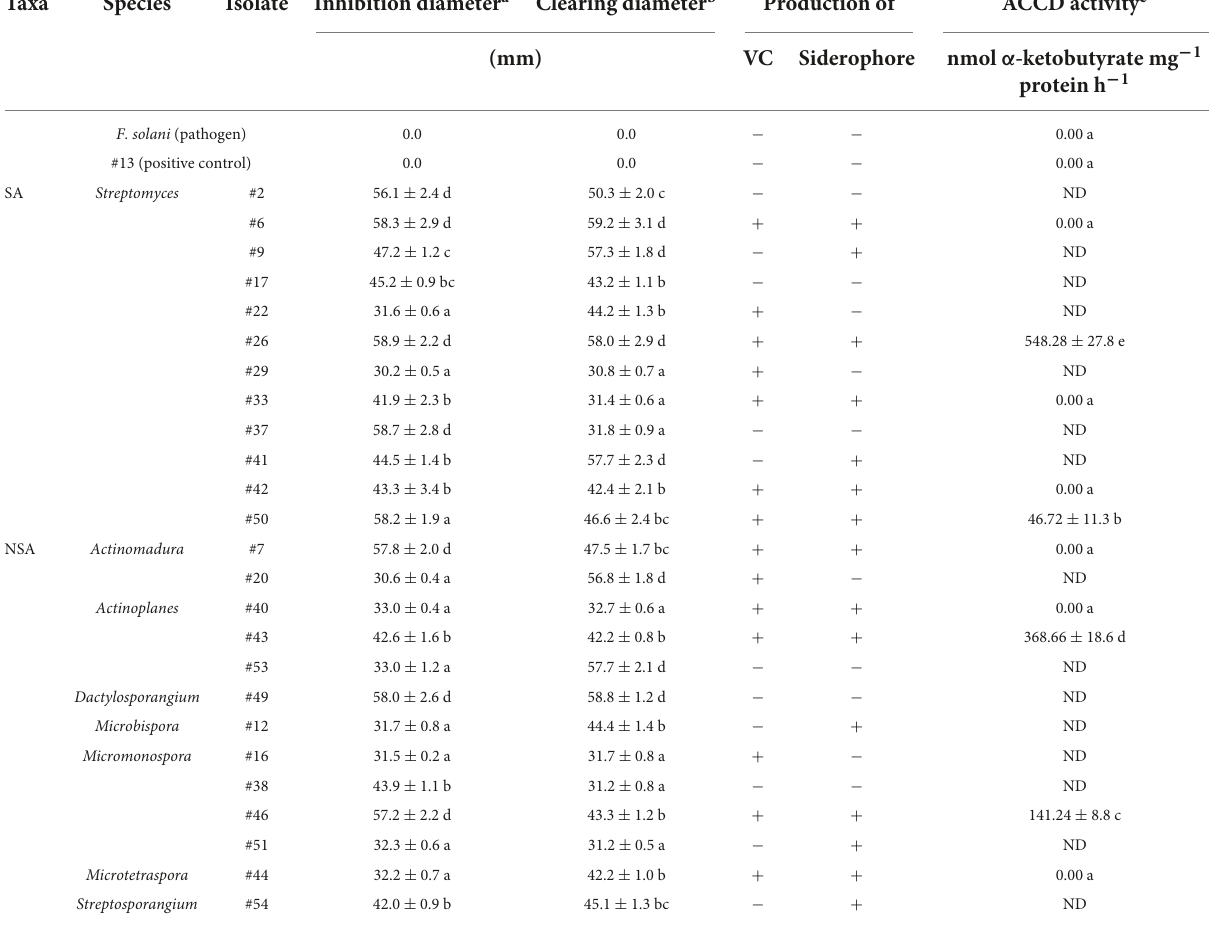
TABLE 1 In vitro antagonistic and ACCD enzymatic activities by actinobacterial isolates against Fusarium solani.